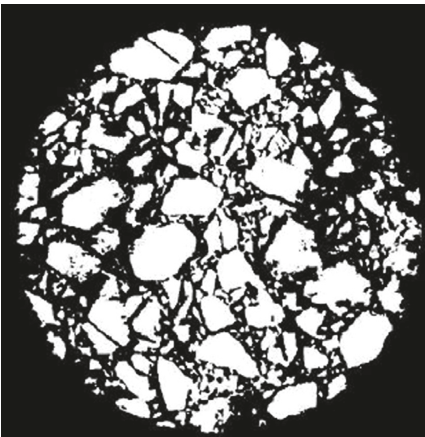
Figure 8: Otsu method.